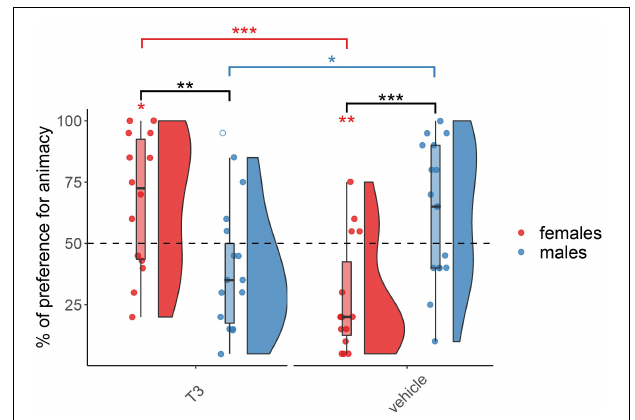
FIGURE 3 | Preference for animacy for the chicks tested 3 days after hatching injected with T 3 or vehicle. To best represent the data, we used raincloud plots. Black asterisks indicate a significant difference between sexes (females red and males blue) within each injection group. Red asterisks above a red horizontal line indicate a significant difference between females of each injection group. Blue asterisks above a blue horizontal line indicate a significant difference between males of each injection group. Red asterisks indicate a significant difference from chance in females. *** indicates p < 0.001, ** indicates p < 0.01, * indicates p < 0.05. Filled red dots represent female and blue male subjects, empty dots represent outliers, which were removed from the